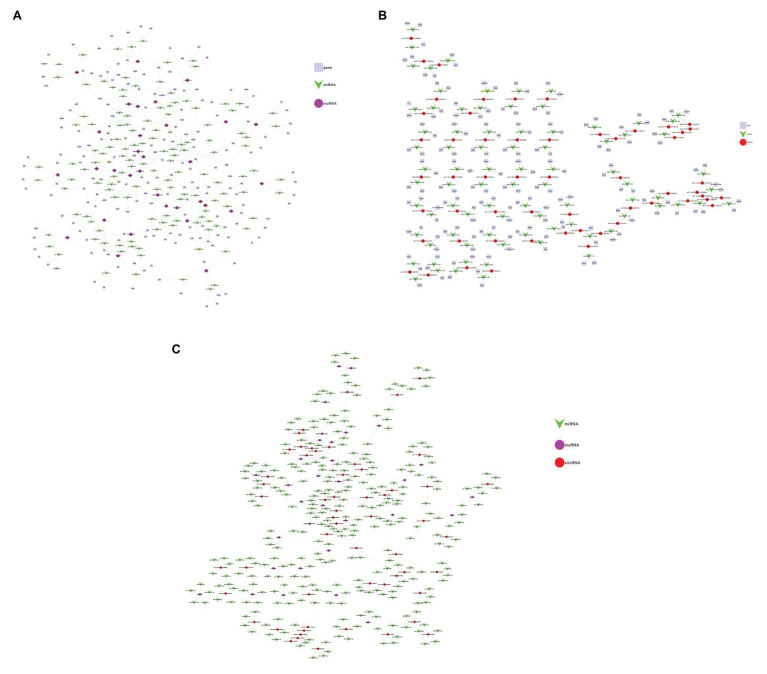
Construction of the lncRNA/circRNA-miRNA-mRNA Network. (A) Network analysis of lncRNA-miRNA-mRNA. The square nodes represent mRNA. The triangle node represents miRNA. The round node represents lncRNA. (B) Network analysis of circRNA-miRNA-mRNA. The square nodes represent mRNA. The triangle node represents miRNA. The round node represents circRNA. (C) Network analysis of lncRNA-circRNA-miRNA. The purple nodes represent lncRNA. The green node represents miRNA. The red node represents circRNA.